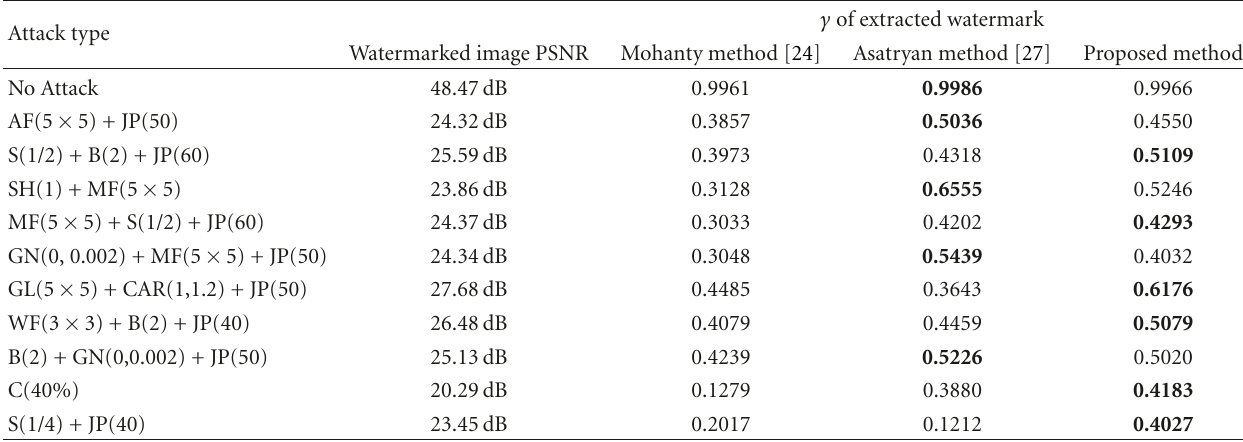
Table 8: The quality of extracted watermark from Baboon image (512 × 512) with watermark size 256 × 256 (Figure 11(b)) versus several attacks in di ff erent methods.